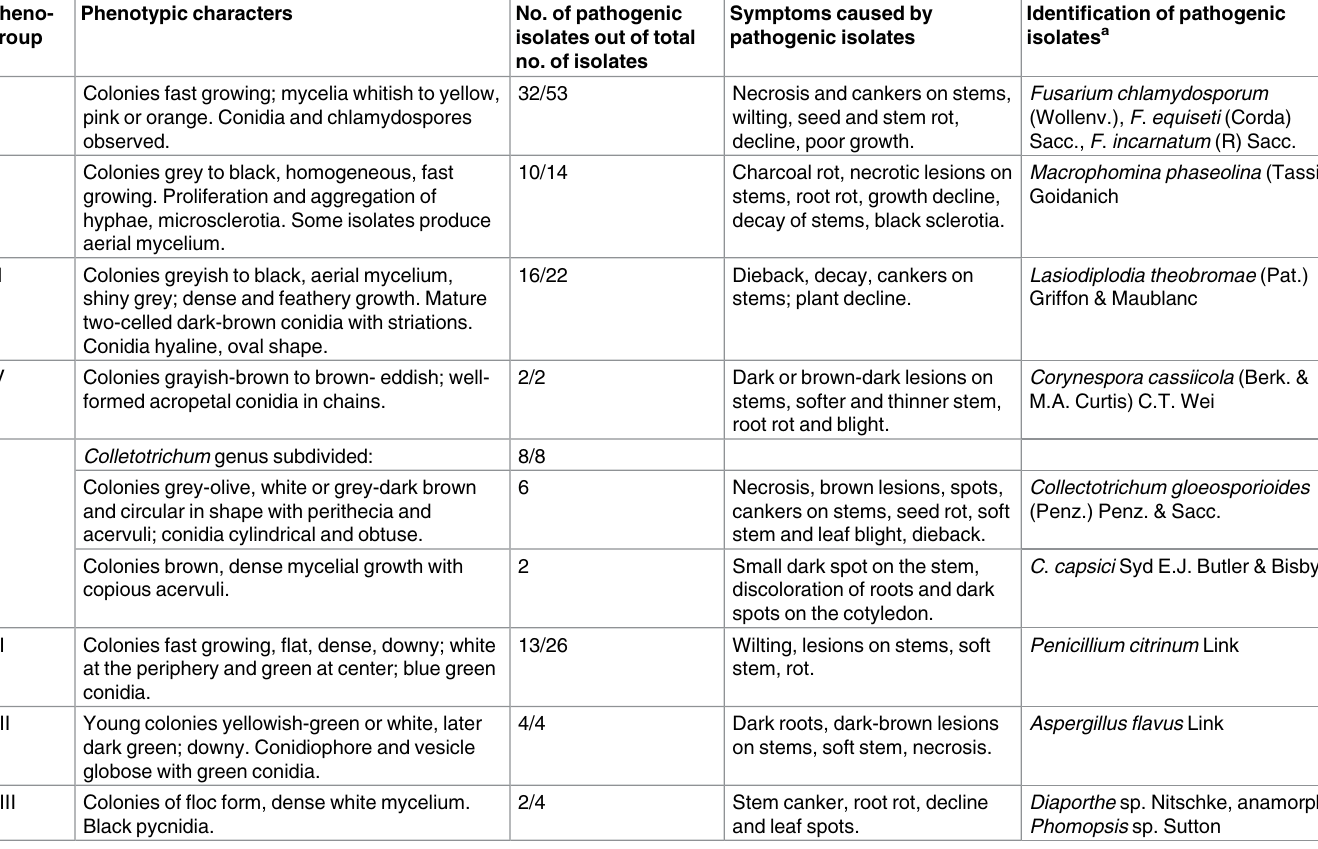
Table 2. Phenotypic characteristics and pathogenicity of the fungal isolates from common bean (cv. INTA Rojo). Phenotypicfeatures of fungal iso- lates grown on nutrient agar were compared, and the phenotypically similar isolates were designated to the same ‘phenogroup’. Pathogenicity was tested on lima beansunder controlledconditions.